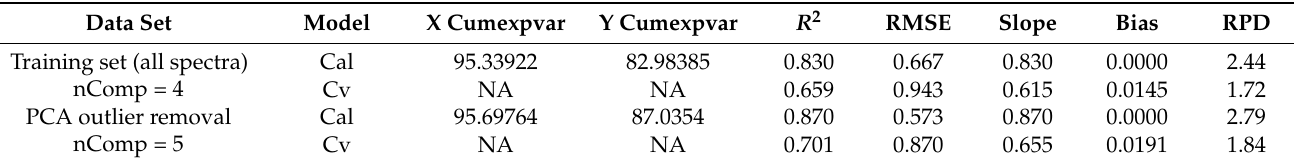
Figure 17. iPLS selected intervals ( left ) and iPLS prediction models ( right ) for TSS data. Table 5. iPLS models for TSS data.